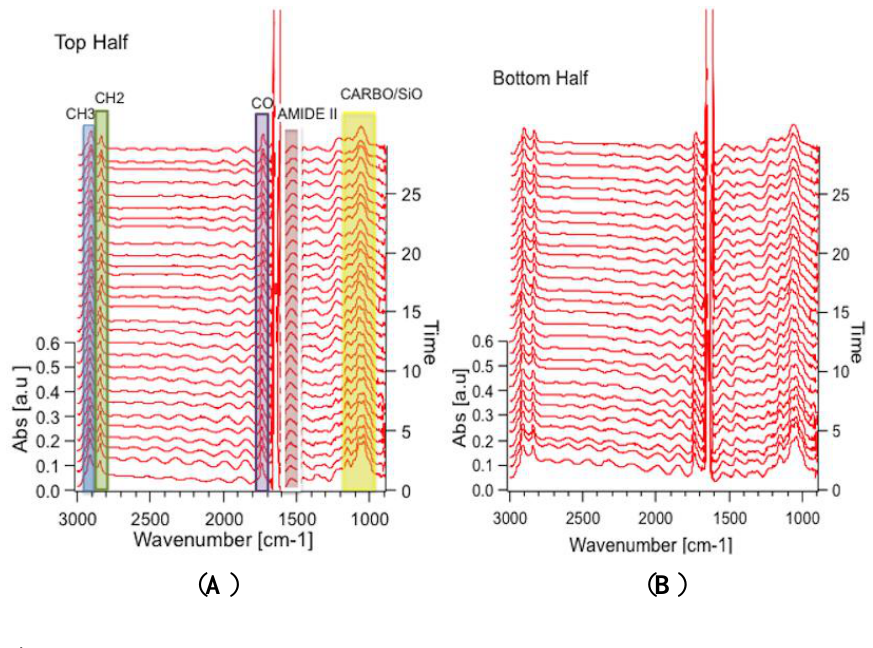
Figure 7. ( A ) Time lapse sequence of spectra created from spatially averaged IR absorption spectra over the top half of the cell in Figure 6. The sequence ranges between t = 3 to 8 h. Functional groups are highlighted in the spectral stack; blue : CH green : CH (2834–2863 cm −1 ); purple : CO (1710–1756 cm −1 ) from a phospholipid or ester; 2 red : amide II (1500–1570 cm −1 ); yellow : carbohydrate/silica (1016–1186 cm −1 ); and (B) Sequence of spectra created from the same dataset as the spectra stack in Figure 7 A , spatially averaged over the bottom half of the